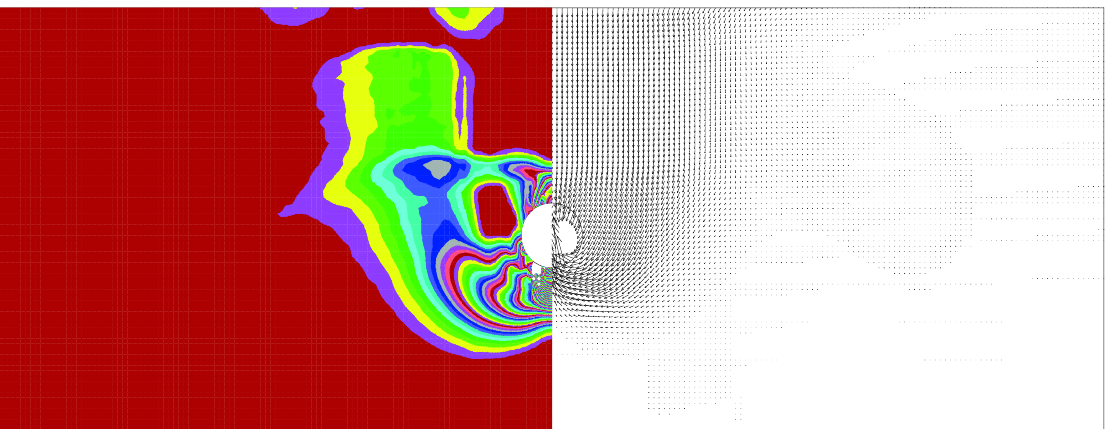
Figure 11. Shear strain rate (SSR) and velocity plot for C/D = 3, γD/S u = 1 .